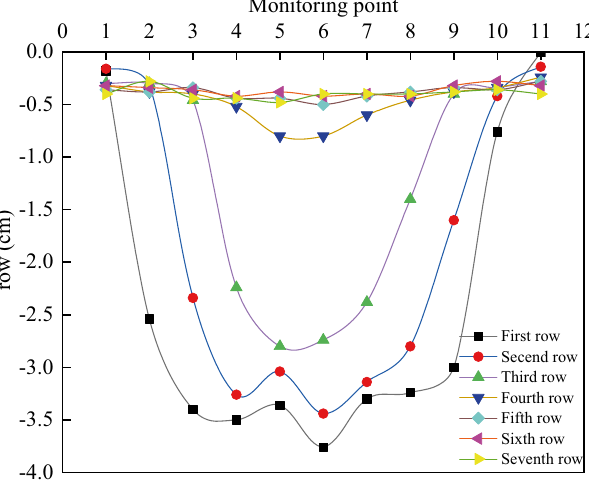
Figure 13. Subsidence and displacement map for each row of measuring points after the end of the excavation.